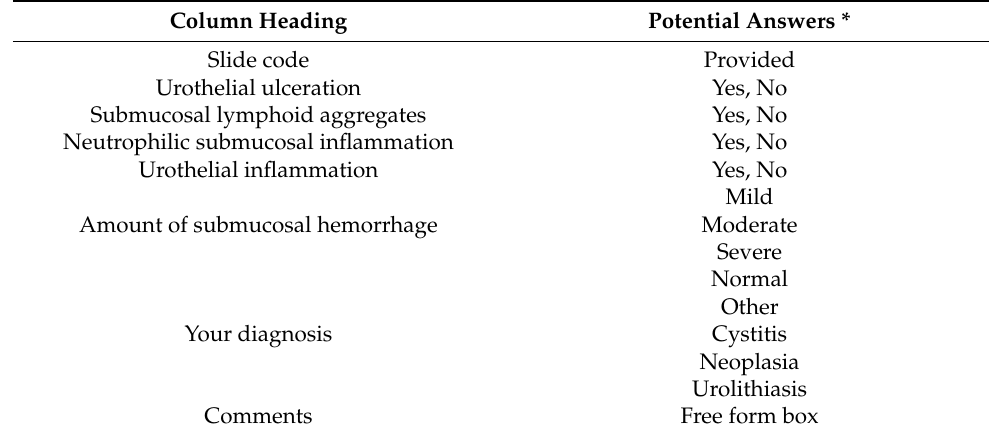
Table 2. Histological criteria to be assessed by the pathologists in worksheets three and four (canine and feline), using the predictive tool. Column Heading Potential Answers